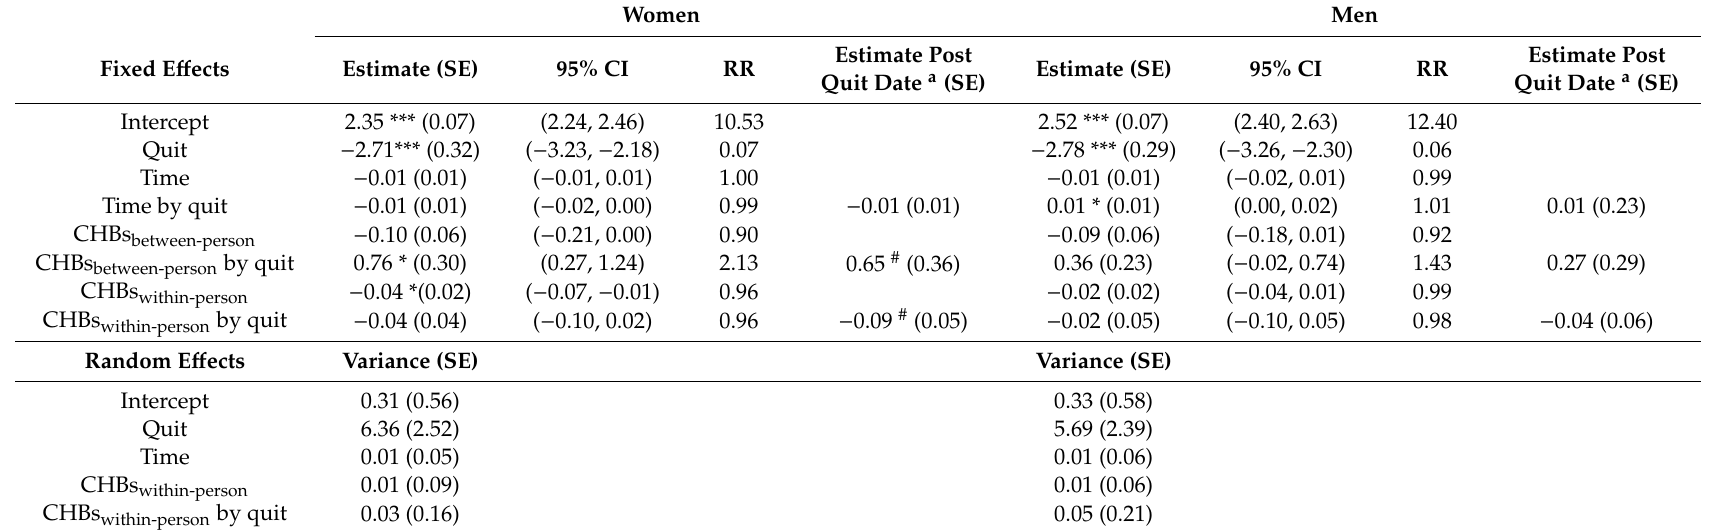
Table 3. Generalized linear mixed negative binomial model of daily smoking regressed on daily CHBs and on interaction with quit date for women and men. Women